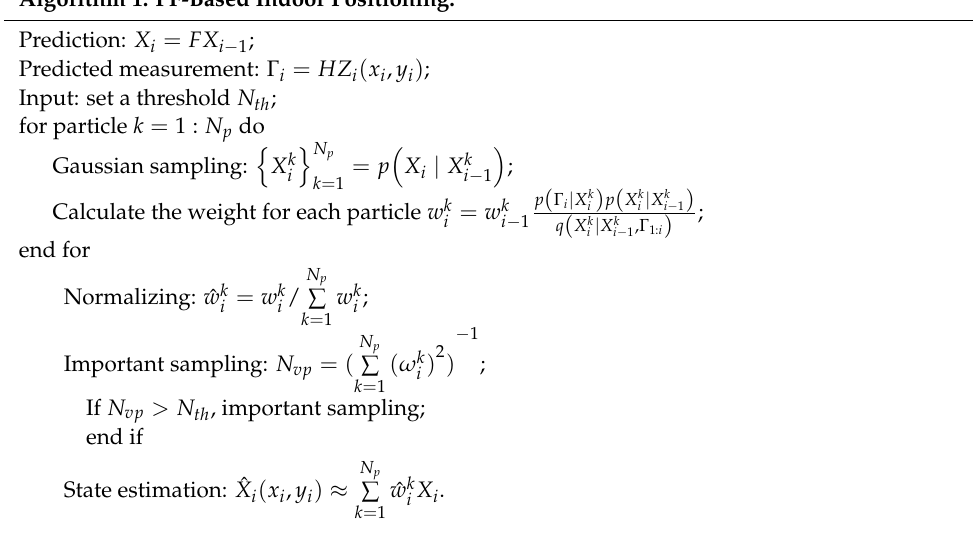
Algorithm 1. PF-Based Indoor